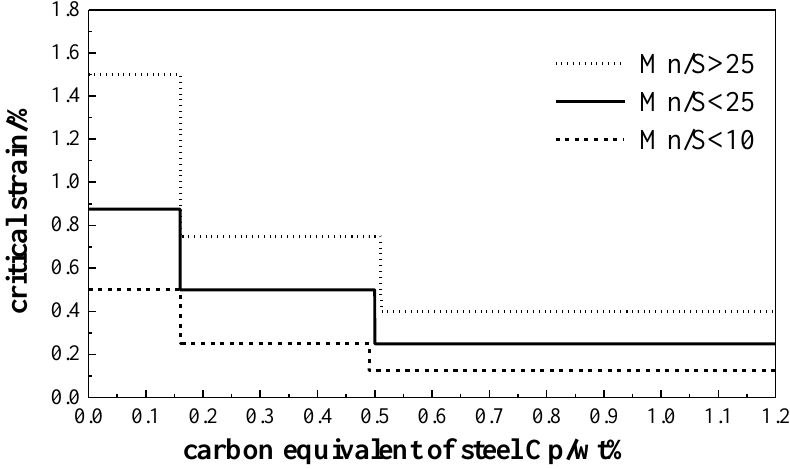
Figure 8. Relationship between the critical strain and carbon equivalent of